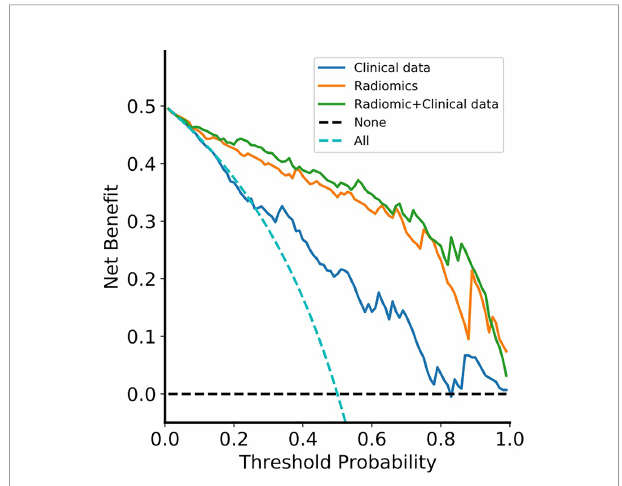
FIGURE 6 | Decision curve analysis for the radiomic-clinical nomogram, radiomics model and clinical model. The decision curve showed that if the threshold probability was higher than 20%, then using the radiomic-clinical nomogram to differentially diagnose CS-PAs and CPs has a greater advantage than using a radiomics model and simple clinical model in terms of clinical application. Clinical data, clinical model; Radiomics, radiomics model; Radiomic+Clinical data, radiomic-clinical